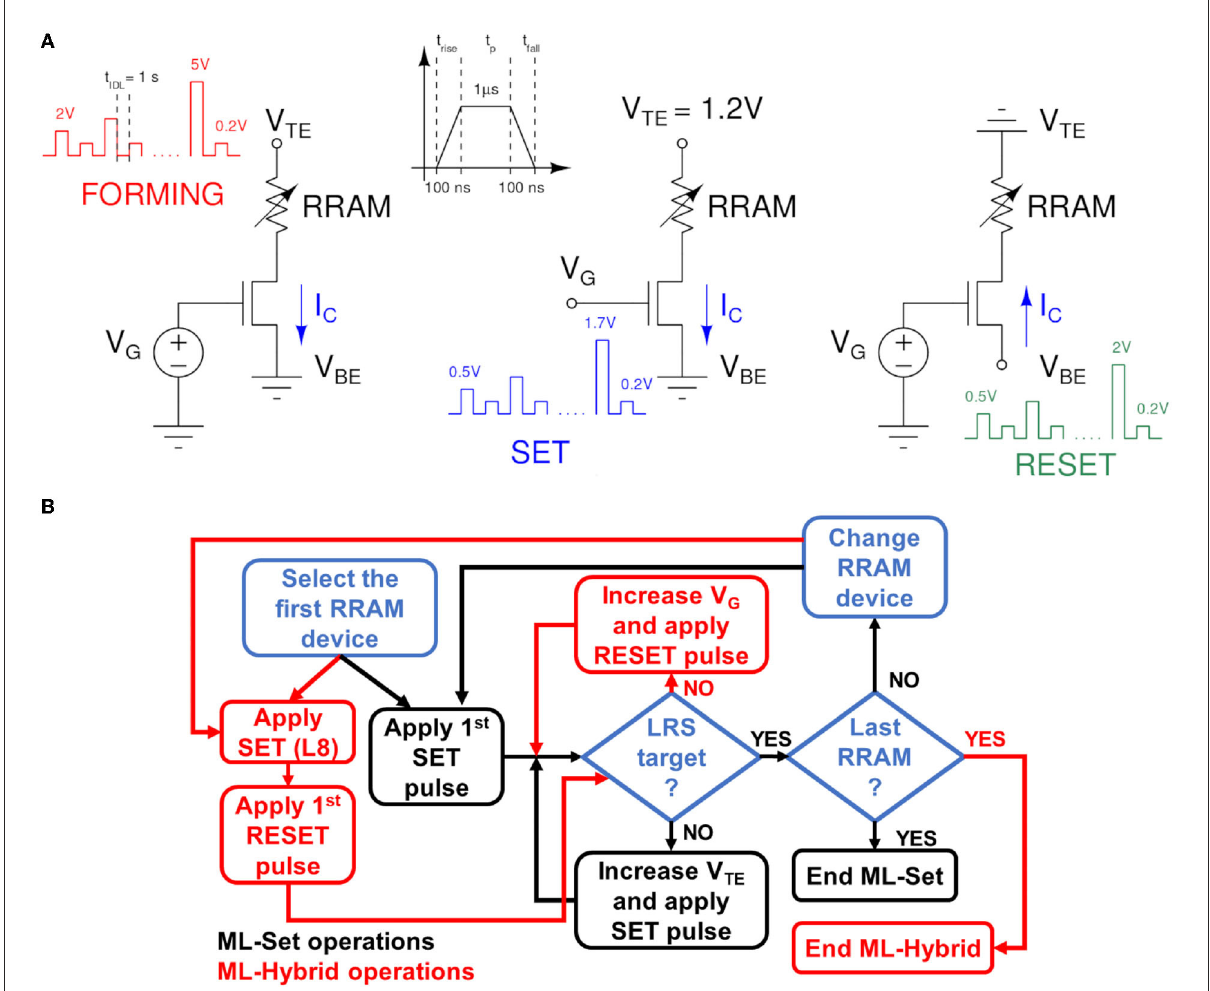
FIGURE3 (A) Algorithms used in RRAM forming, set, and reset operation modes. The voltages during the operation and the verify phases are evidenced. (B) Global flowchart scheme, representing the different steps for ML-SET and ML-Hybrid